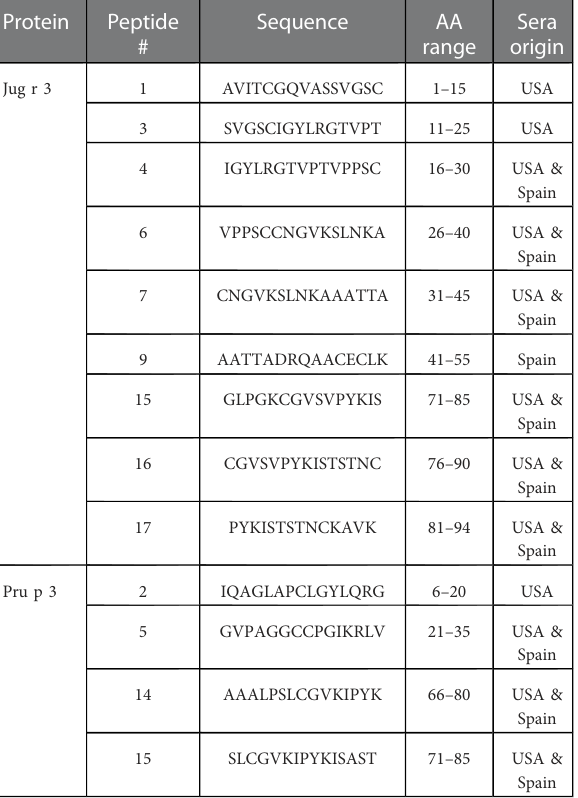
TABLE 8 Major IgE binding peptides of Jug r 3 and Pru p 3 by region.